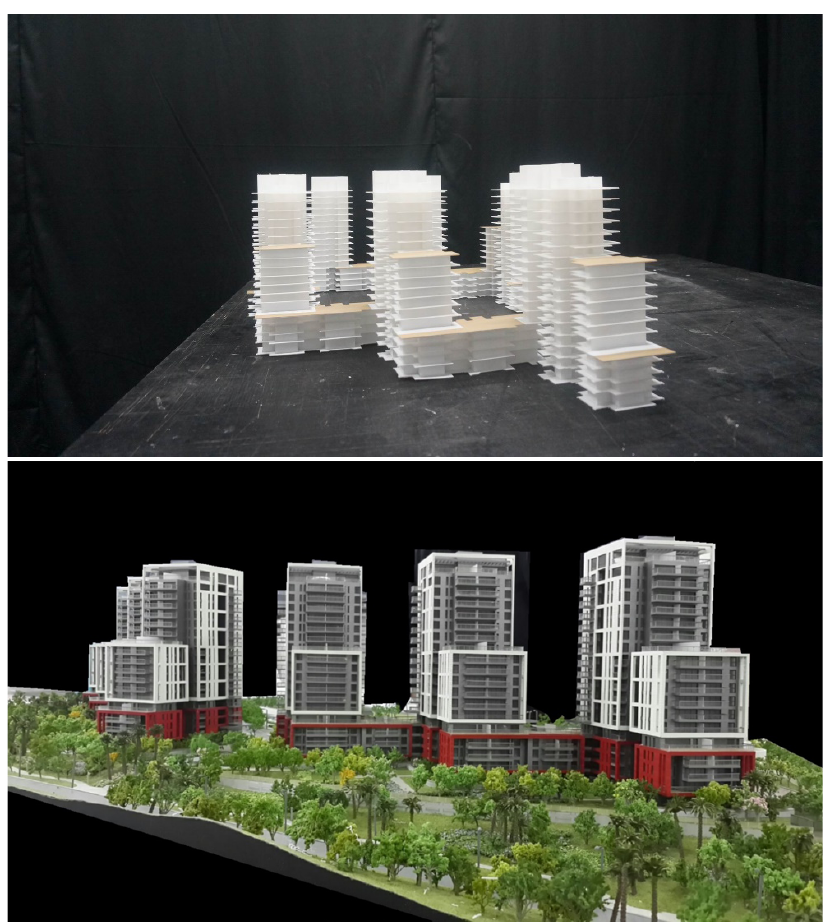
Figure 4. The HH model with and without the ‘dress.’ Source: K. Braz private collection (2014).